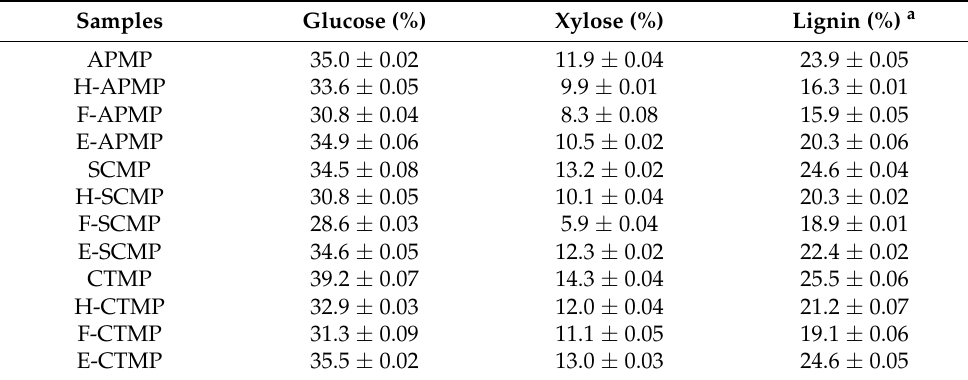
Table 1. Chemical compositions of